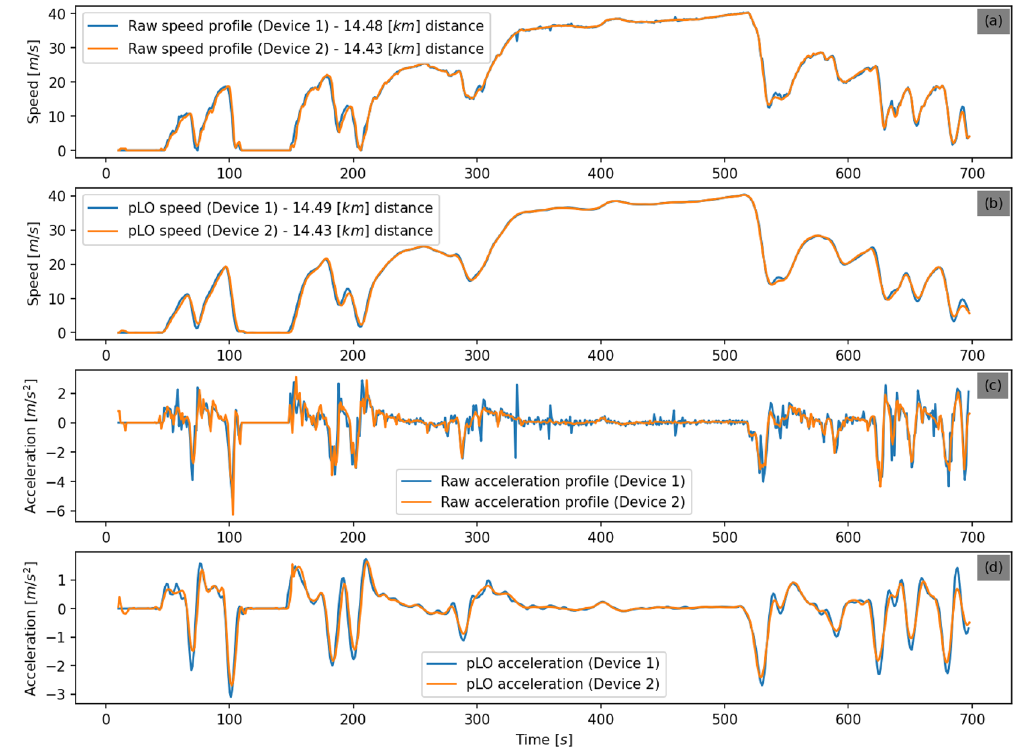
Figure 4. Campaign 2: The speed and acceleration profiles for the same trajectory with two devices, before and after the application of pLO method.